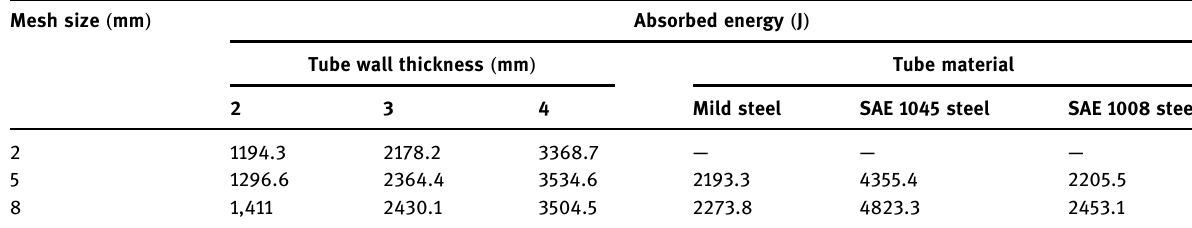
Table 4: Total energy absorbed value of the tube under axial loading dependent on the mesh size Mesh size ( mm ) Absorbed energy ( J